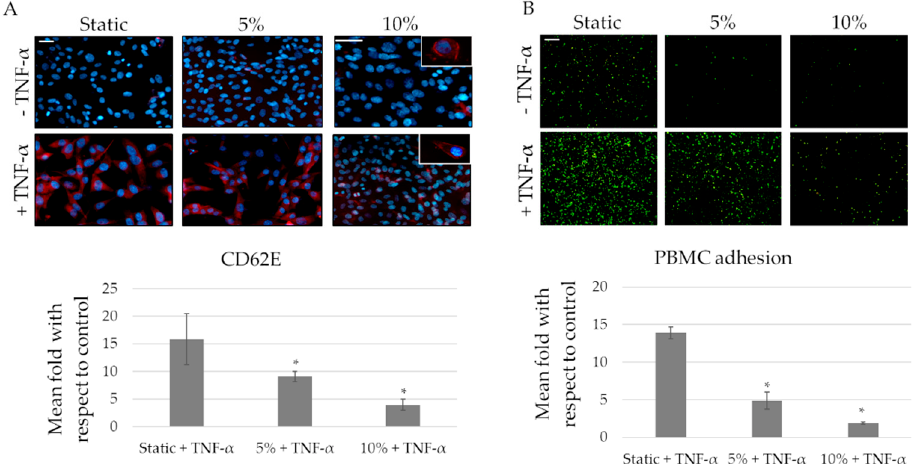
Figure 6. Strain affect inflammation mediated by endothelial cells (ECs). ( A ) Representative immunofluorescence staining for CD62E after mechanical (5 and 10%) and chemical (Tumor necrosis factor-alpha TNF- α 50ng/mL) stimulation. CD62E is observed in red while DAPI is used for nuclear staining. Quantification of positive cells expressing CD62E. Normalization of samples stimulated by TNF- α in relation to the respective control. Scale bar 30 µm * p ≤ 0.05; ( B ) Peripheral blood mononuclear cells (PBMCs) adhesion on ECs. PBMCs are observed in green. Normalization of samples stimulated by TNF- α in relation to the respective control (static, 5% and 10%). Scale bar 25 µm * p ≤ 0.05.